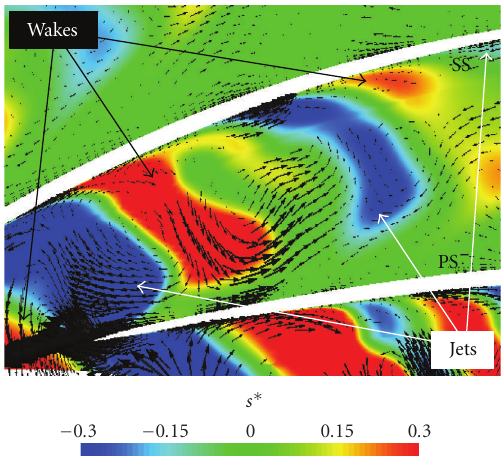
Figure 11: Color map of the reduced unsteady entropy and velocity fluctuations with arrows at a given time step, at midsection height.